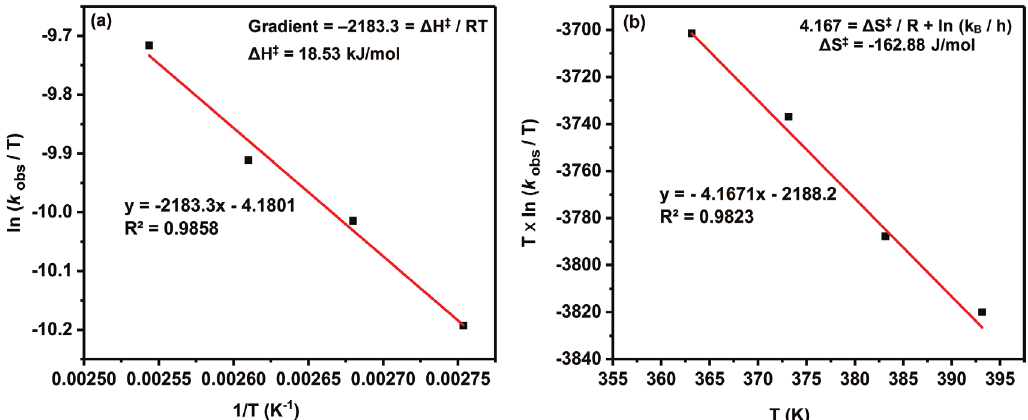
Figure 13: Eyring plots to determine the thermodynamic activation parameters of the reaction according to Eq. 7: (a) enthalpy of activation (ΔH ‡ ); (b) entropy of activation (ΔS ‡